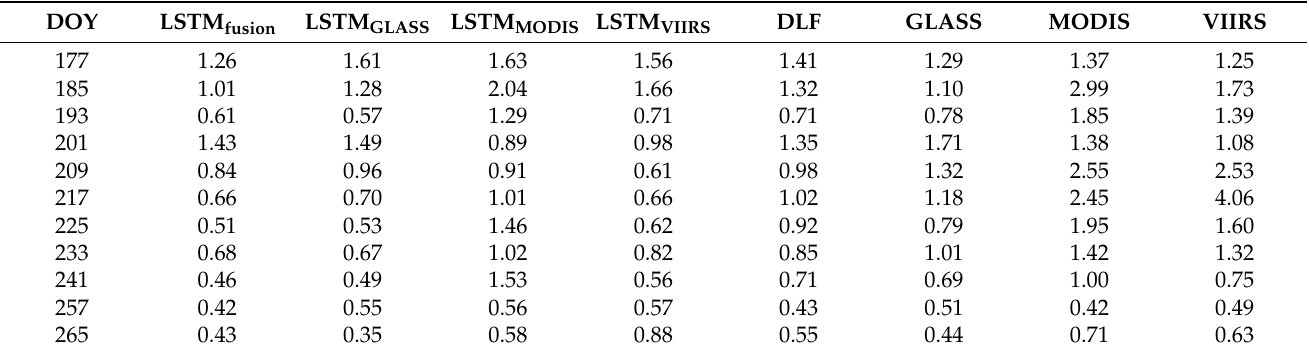
Table 3. RMSE between the retrieved and aggregated reference LAI on multiple ground-measured dates in 2016.